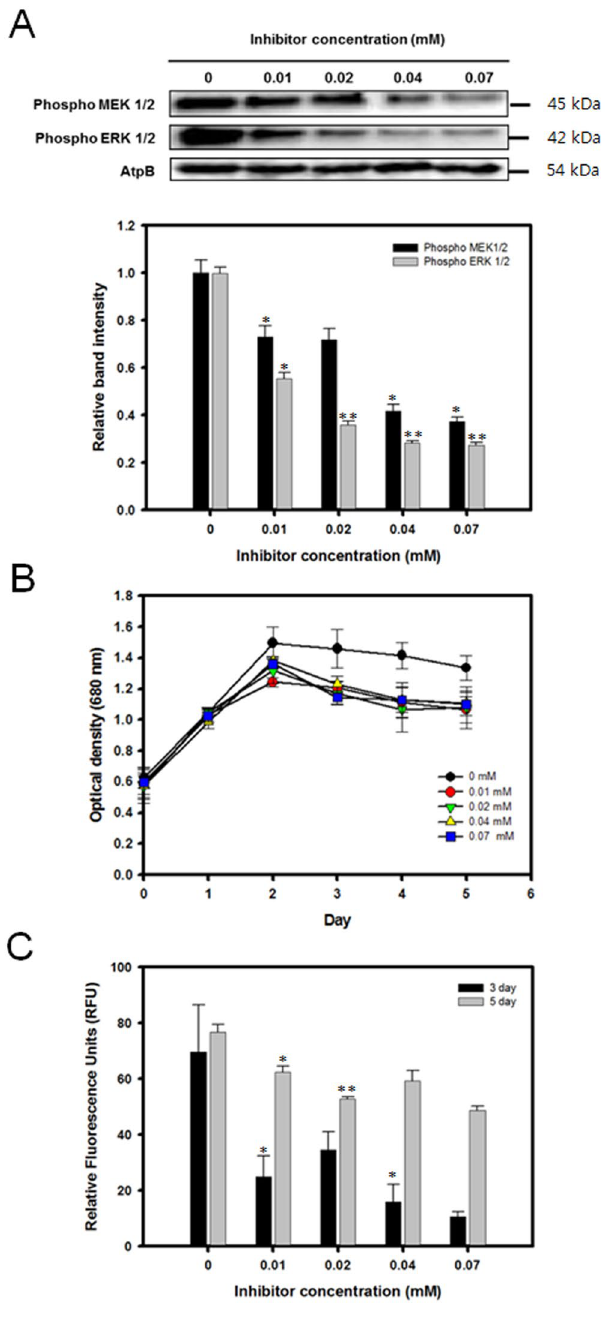
Figure 3. Expression level of MEK-ERK, cell growth profile, and lipid accumulation of C . reinhardtii grown in media containing 0.1 M NaCl and various concentrations of the MEK inhibitor PD98059. ( A ) Western blot analysis against anti-MEK1/2 and ERK1/2. ATP β antibody was detected as a loading control. Full-length blots are presented in Supplementary Fig. S6. ( B ) Cell growth (O.D. 680 nm). ( C ) Nile red fluorescence measurement at 3 and 5 days after osmotic stress induction. Data are represented as mean ± SD (n = 3). Significant differences were determined by Student’s t-test and indicated by asterisks ( * P < 0.05, ** P < 0.01, *** P <